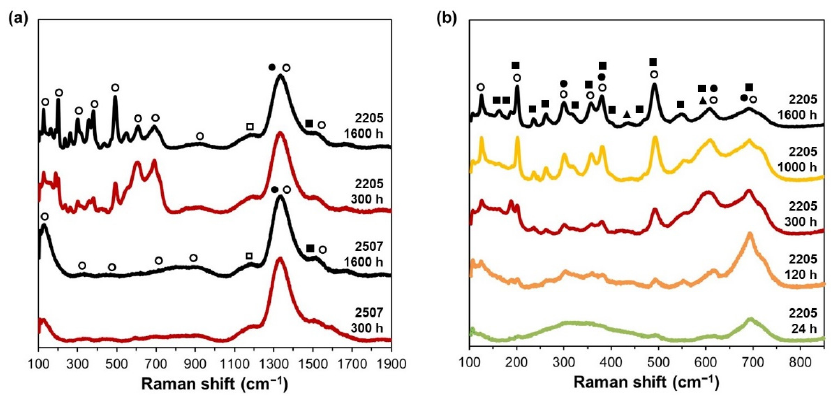
Figure 3. Raman spectra at: ( a ) infrared and ( b ) visible laser region, corresponding to oxide scales of DS2205 and DS2507 after several exposure times to molten salts. The symbols denote the phases: chromium oxides (e.g., ● FeCr 2 O 4 , and ▲ LiCrO 2 ); iron oxides (e.g., ○ LiFeO 2 and ■ LiFe 5 O 8 ); and □ NiO. (cid:3)